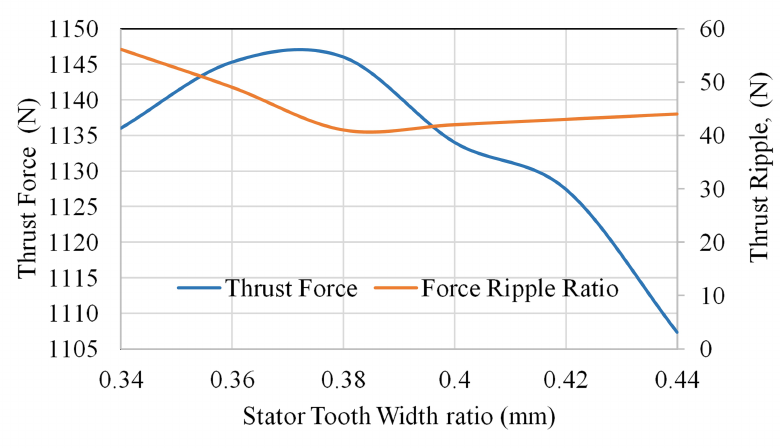
Figure 8. Force ripple and thrust force variation with stator tooth width for dual mover yokeless multi-tooth PMFSM.